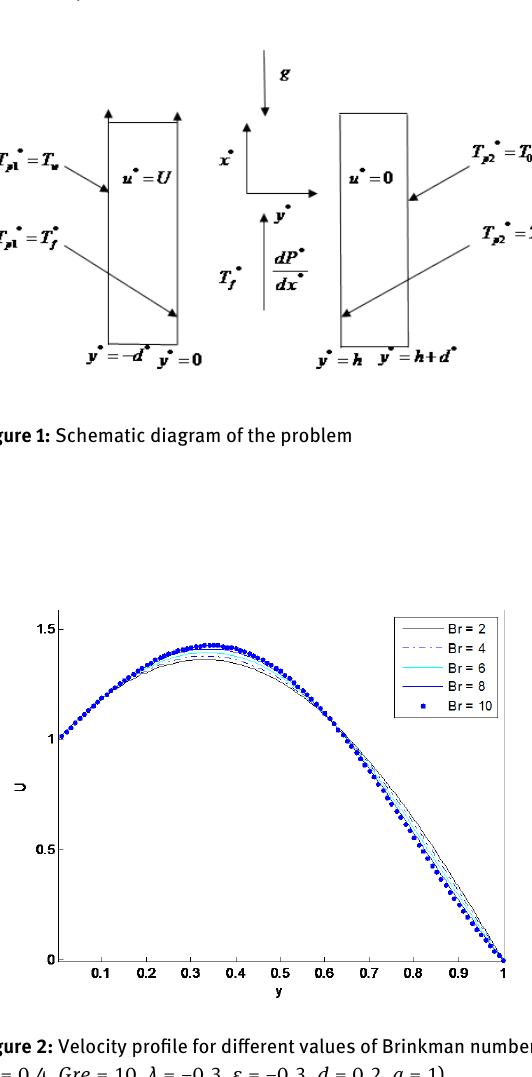
Figure 2: Velocity profile for different values of Brinkman number Br ( S = 0.4 , Gre = 10 , λ = −0.3 , ε = −0.3 , d = 0.2 , q = 1 )